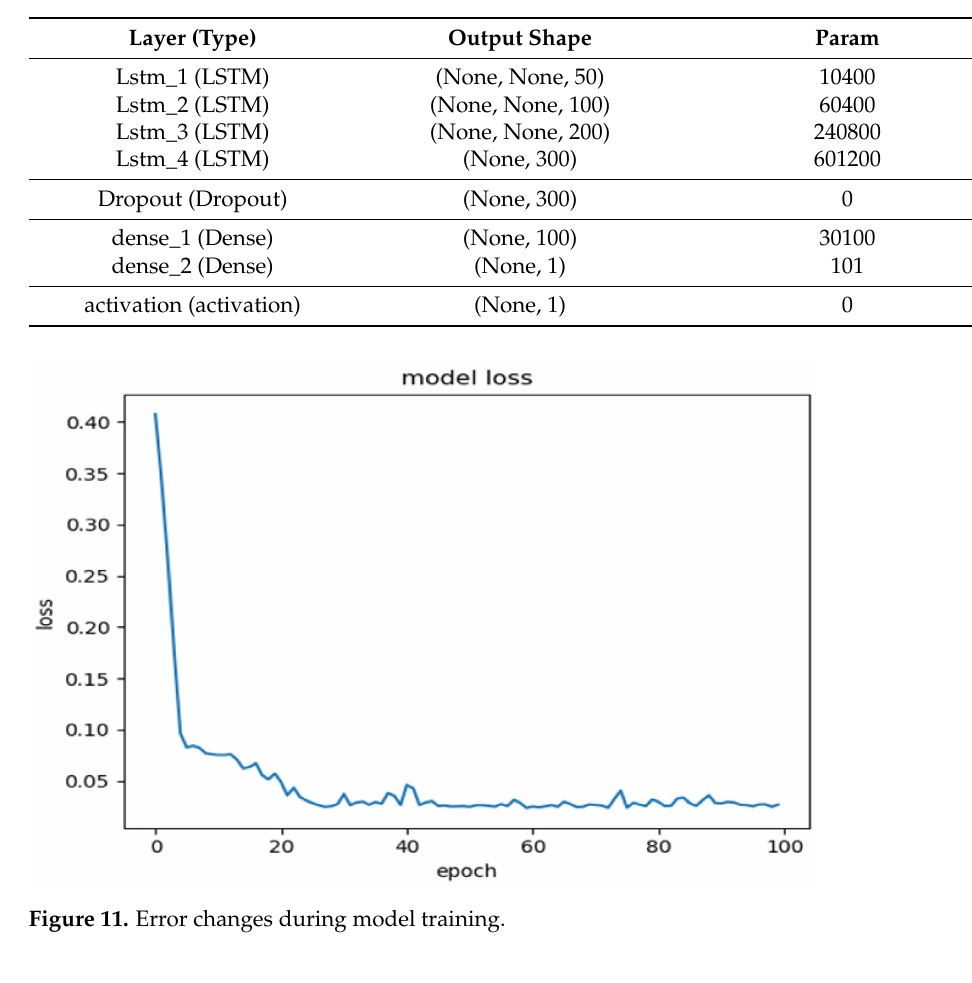
Table 2. LSTM network structure table.